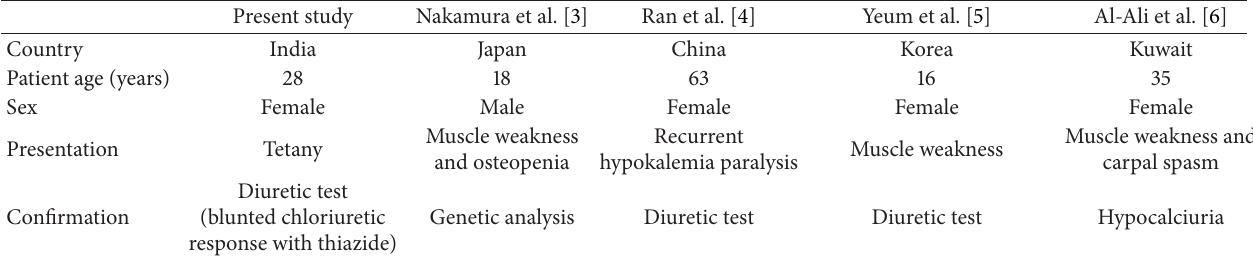
Table 3: GS with